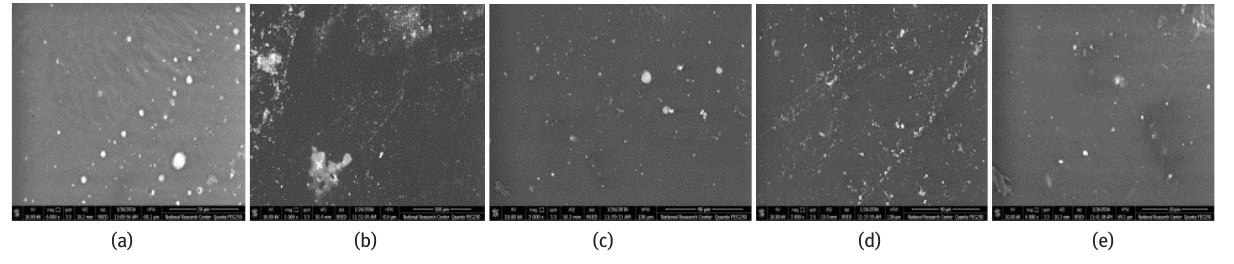
Figure 6: SEM of a)MtT2, b) MtT4, c)MtT6, d)MtT8 and e)MtT10. (The magnification equal